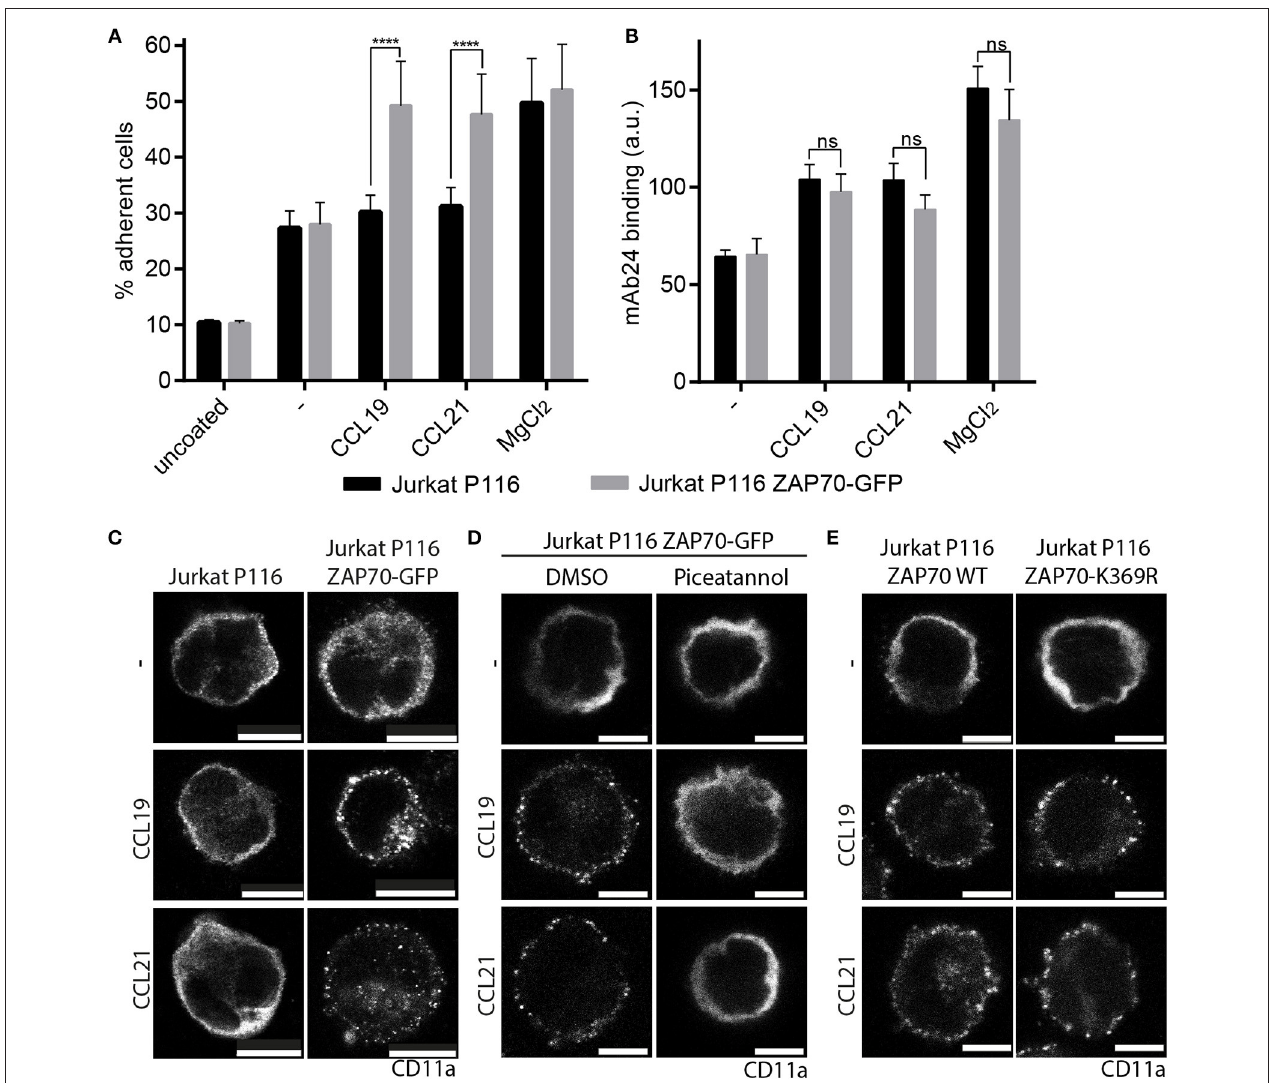
FIGURE 5 | ZAP70 controls CCR7-mediated inside-out signaling to LFA-1. (A) Arrest of Jurkat P116 cells lacking ZAP70 and Jurkat P116 cells reconstituted with ZAP70-GFP on immobilized ICAM-1 in the presence or absence of CCL19, CCL21, or MgCl 2 . Mean ± SEM of three independent experiments. (B) Binding of the β 2 -integrin high-affinity reporter mAb24 to Jurkat P116 and Jurkat P116 ZAP70-GFP cells upon CCR7 triggering for 10min. Mean ± SEM of five independent experiments. (C–E) Confocal images of CD11a staining on Jurkat P116, Jurkat P116 ZAP70-GFP, or Jurkat P116 ZAP70-K369R-GFP cells before and after chemokine stimulation (0.5 µ g/ml, 10min). (C) no pre-treatment. (D) pre-treatment with DMSO or piceatannol. Representative images derived from one out of three independent experiments; scale bar, 10 µ m. **** p < 0.0001. ns, not significant.